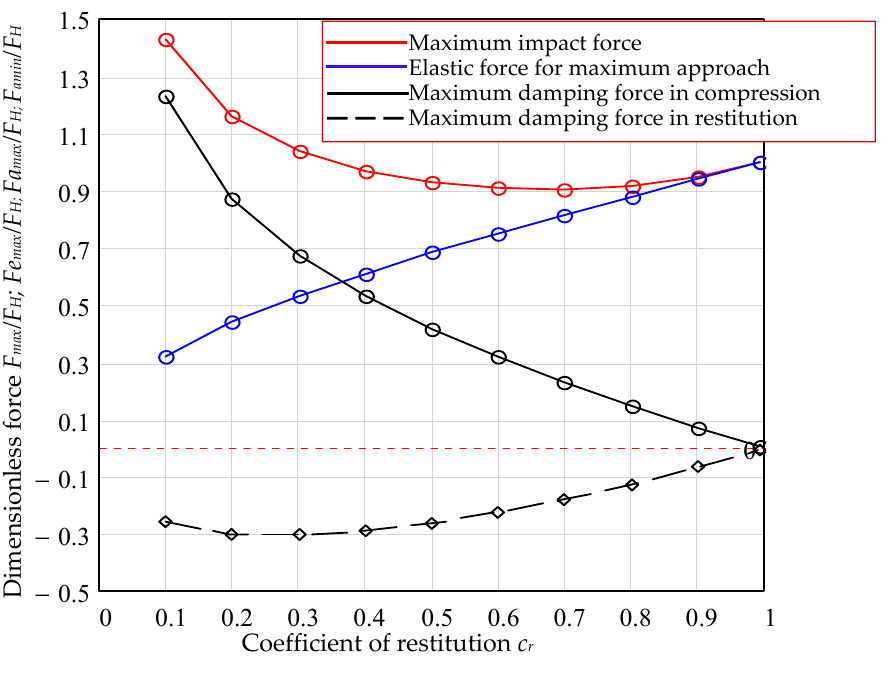
Figure 30. Dependency of F max —maximum impact force, F emax —elastic force corresponding to maximum approach, F amax —maximum damping force for compression phase and F amin —maximum damping force for restitution phase, on coefficient of restitution, c r .